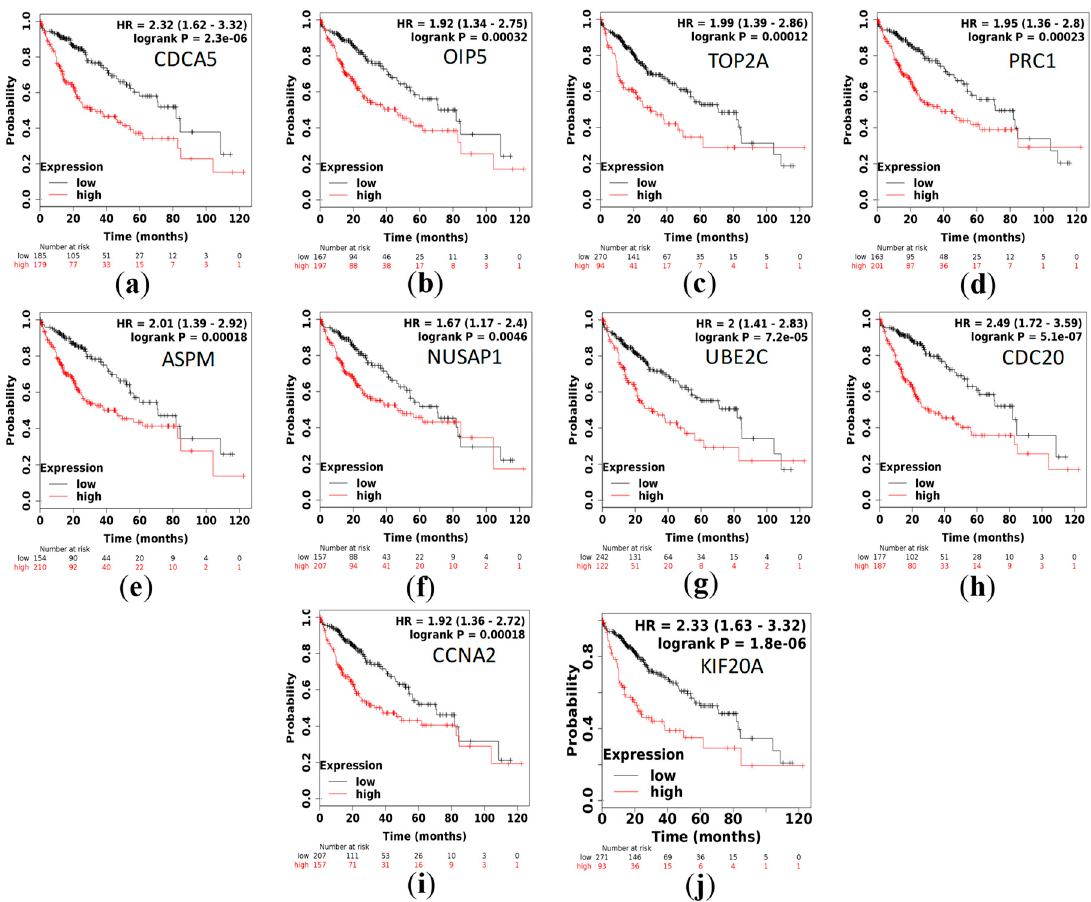
Figure 5. Kaplan–Meier survival analyses of the HCC hub genes. ( a–j ) Overexpression of these HCC hub genes is associated with a significant reduction in overall survival time in HCC patients.